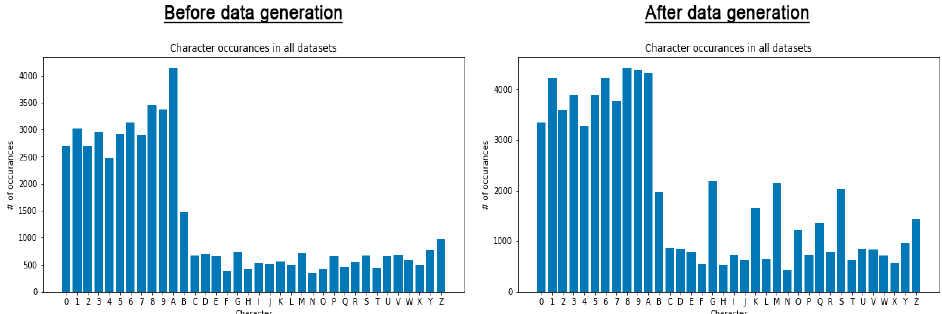
Figure 4. The total number of character occurrences for all datasets before and after data generation.